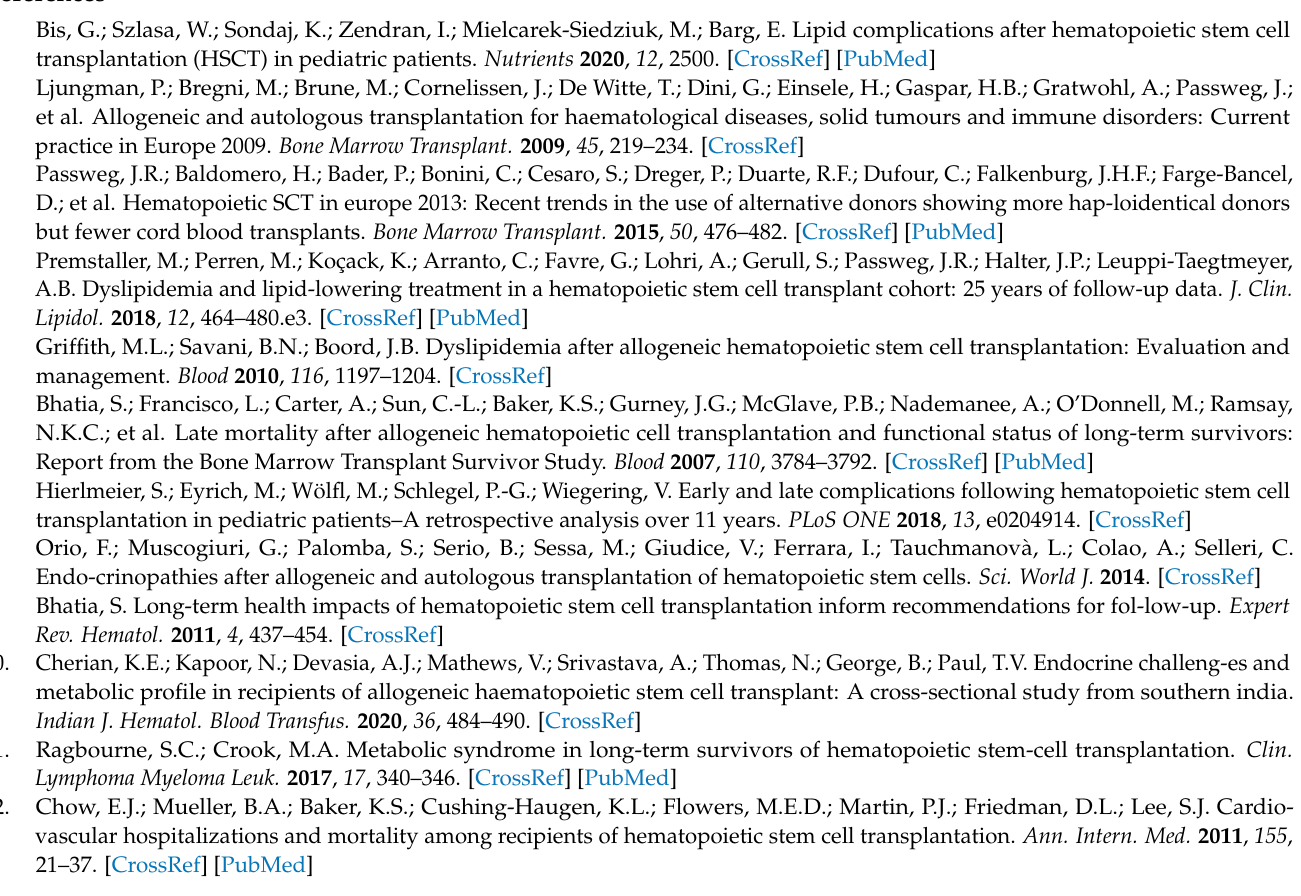
HSCT subjects), Table S6: Difference in the expression of genes in children undergoing the HSCT procedure, with focus on the indication for the transplantations (neoplasm or non-neoplasm), Table S7: Correlation between the expression (or its change ∆ mean and relative change ∆ mean(rel) ) of genes associated with lipid metabolism and its parameters in children undergoing HSCT